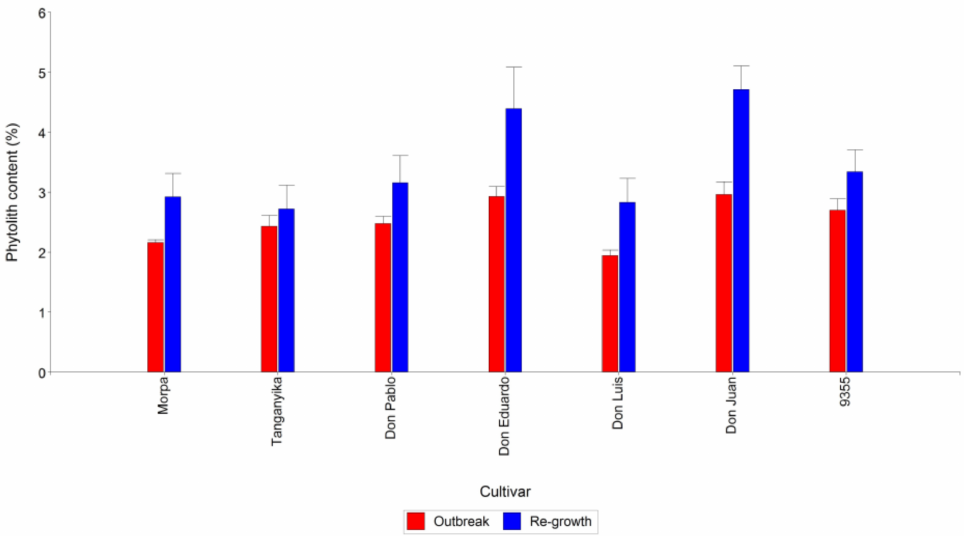
Figure 1. Mean values of the phytolith content (%) in the dry matter of seven weeping lovegrass cultivars at two clipping dates: outbreak and re-growth. Bars indicate standard errors. Table 1. Analysis of variance chart for the mean value of the phytolith content of different weeping lovegrass cultivars in two phenological stages: outbreak and re-growth. Sum of Degrees of Mean Source of Variation F p -Value Squares Freedom Squares